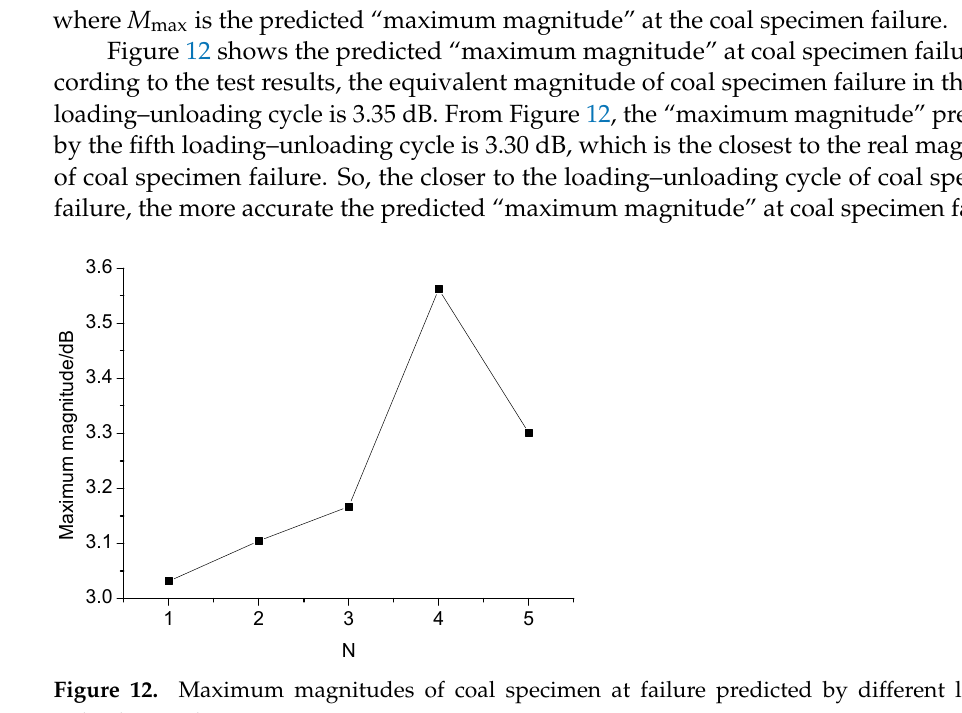
Figure 11. AE b value versus cycle number curves.